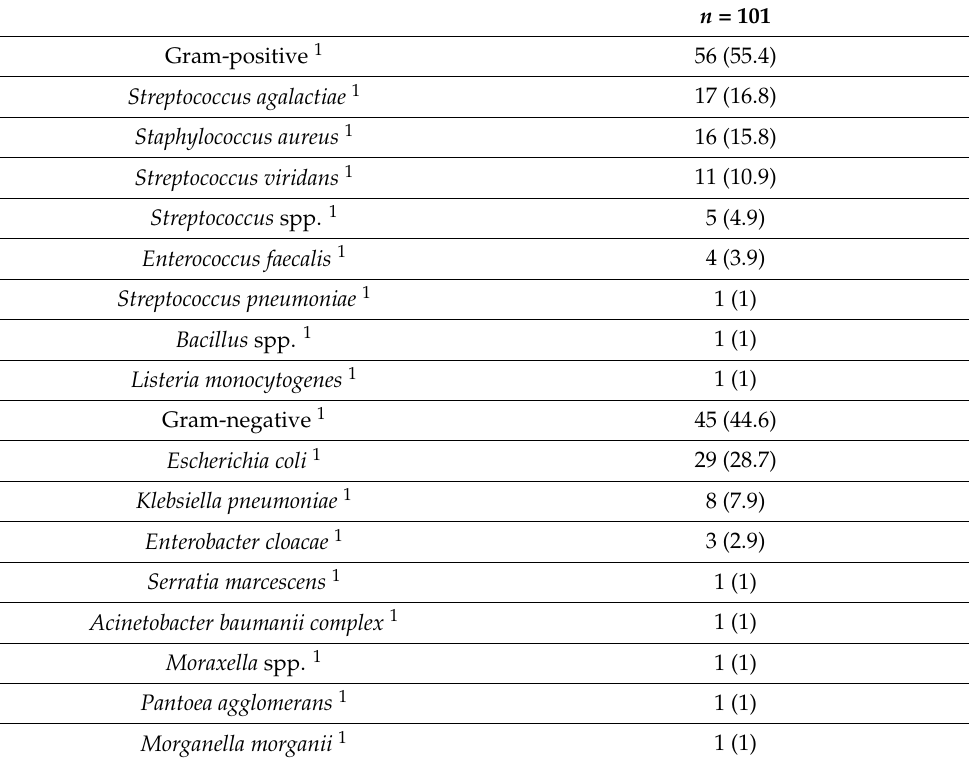
Table 1. Etiologic agents detected in blood culture of patients with early-onset